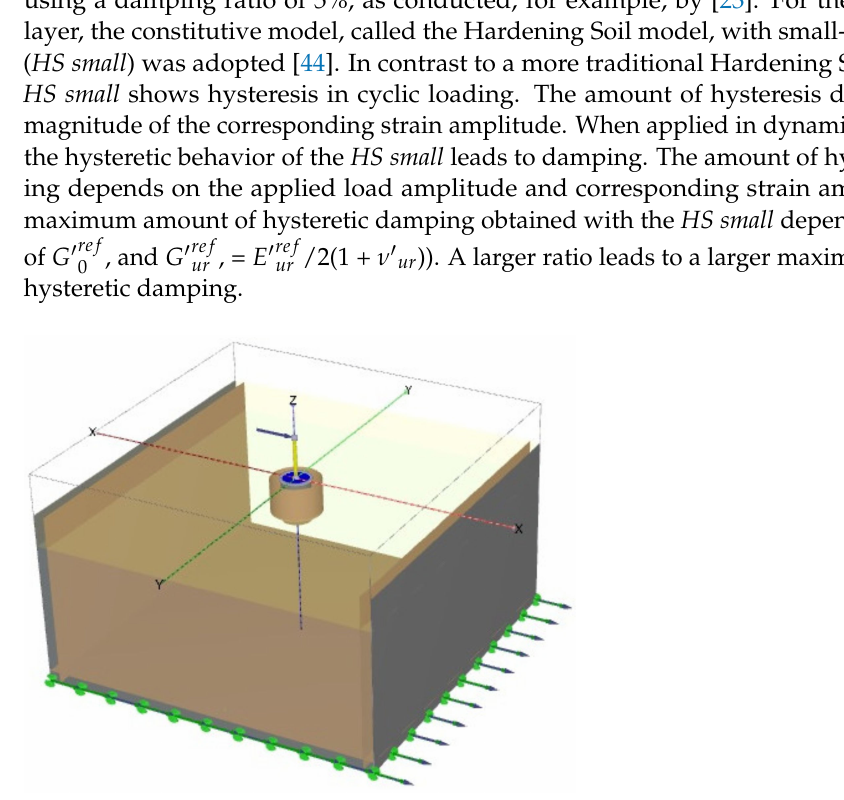
Figure 6. Three-dimensional view of the model, with the evidence of the caisson, modeled pier, and applied